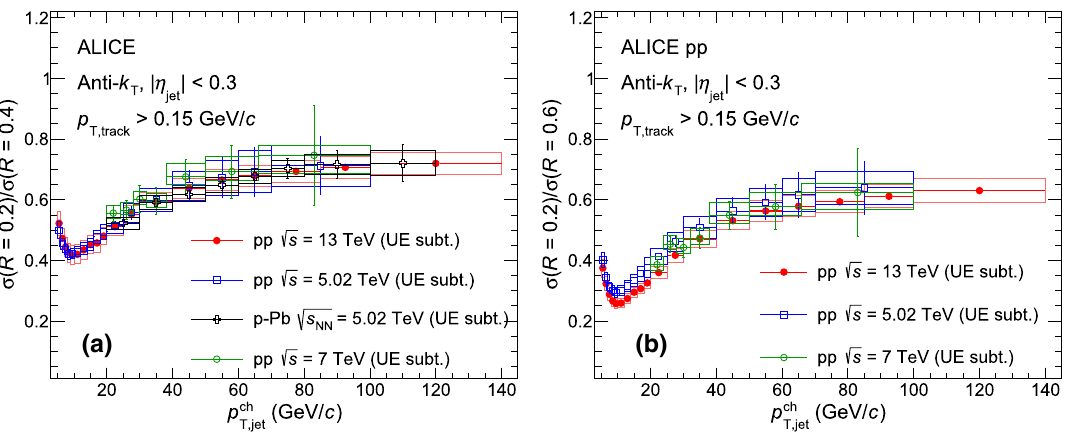
√ s = 5 . 02 [12], 7 [45], and 13 TeV and in